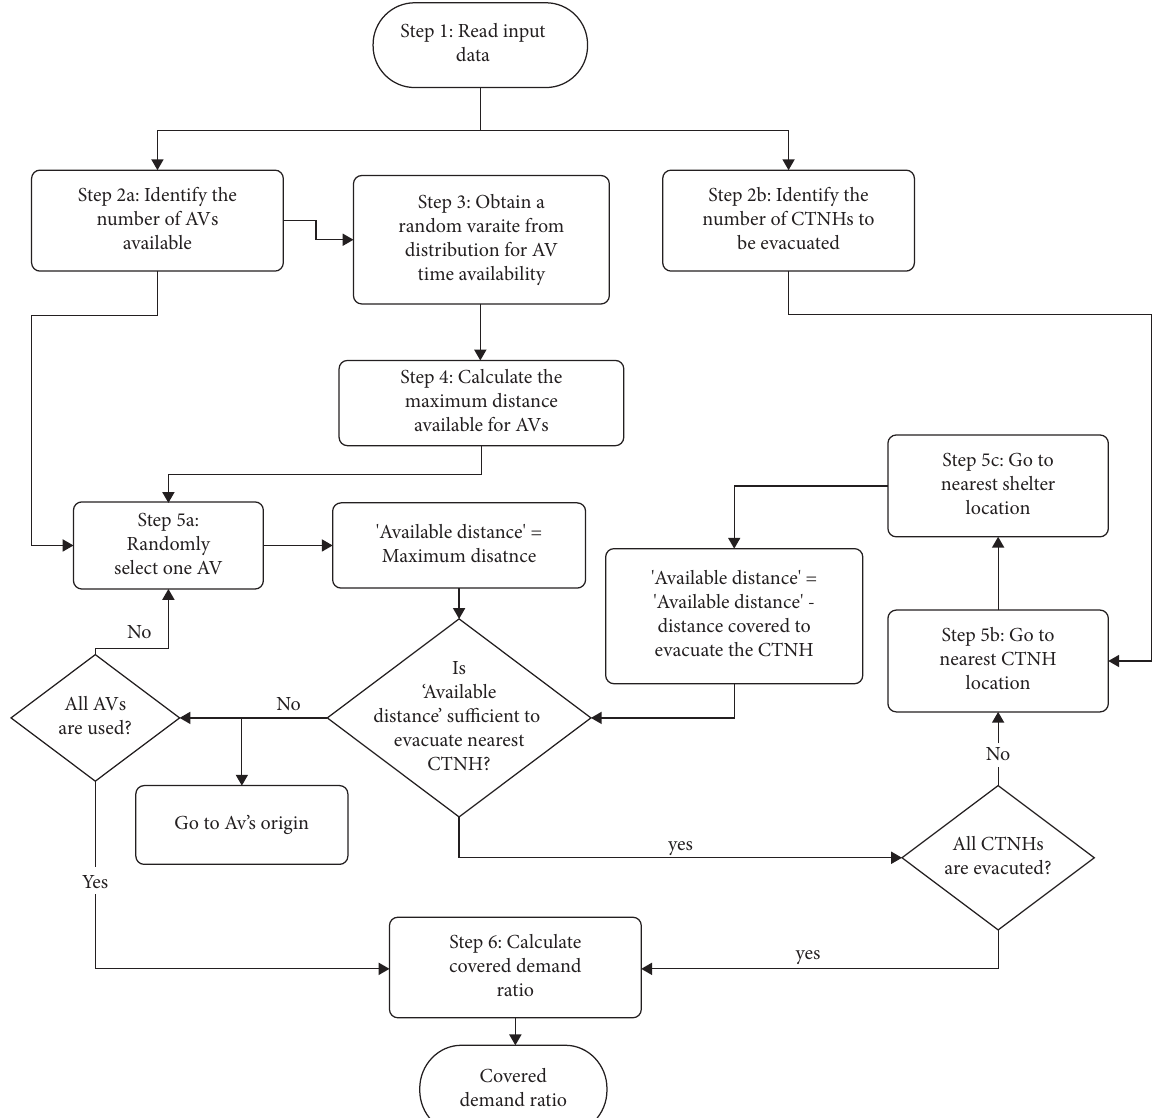
Figure 1: Logic of the Monte Carlo simulation